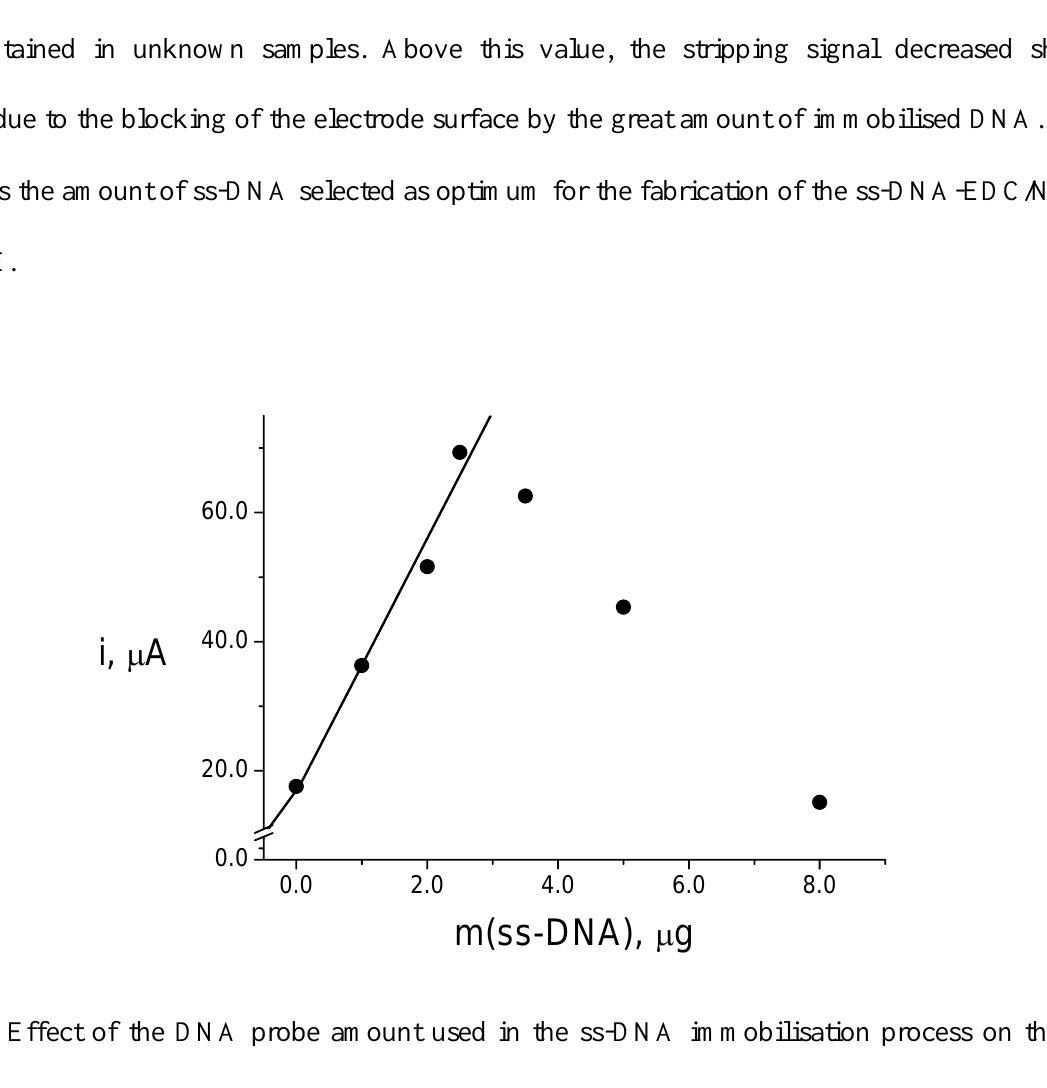
= 24 h. Accumulation drying = 30 sw